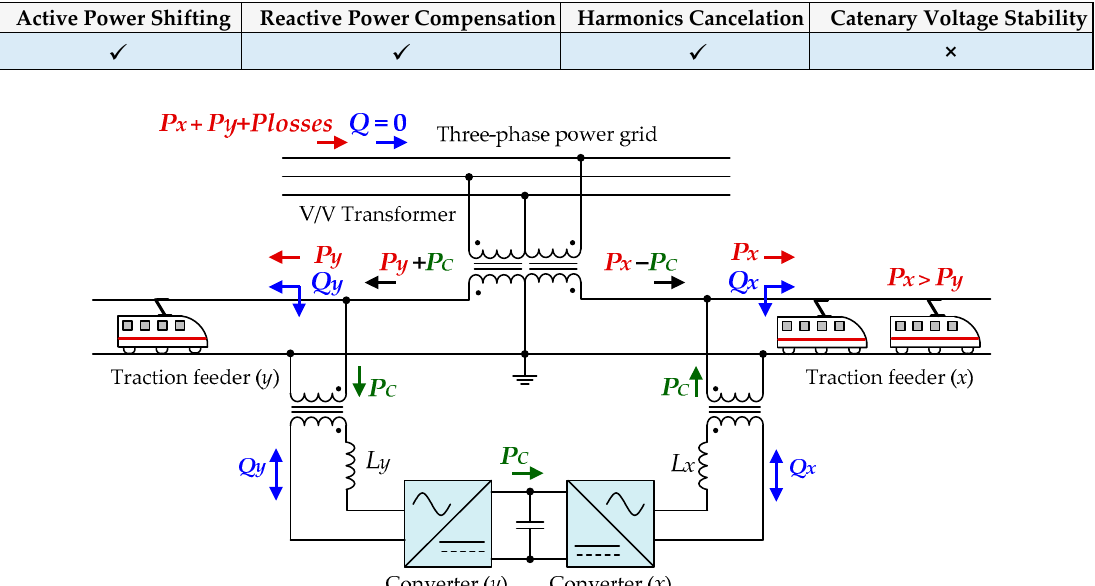
Table 4. Capabilities of the RPC operation mode.